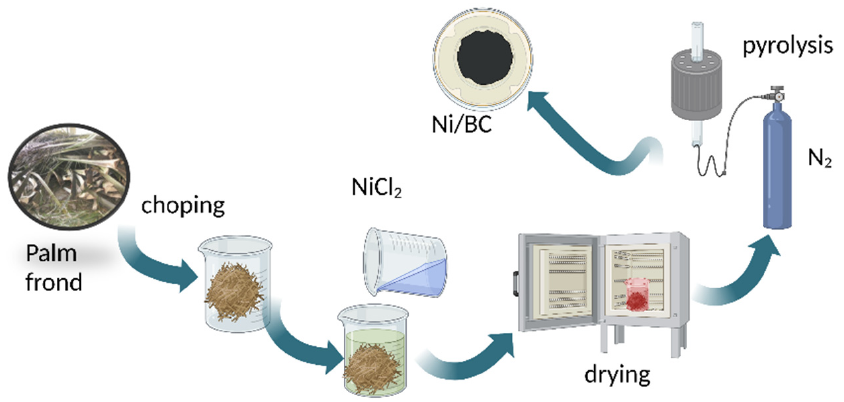
Figure 9. Schematic representation of Ni/BC preparation.